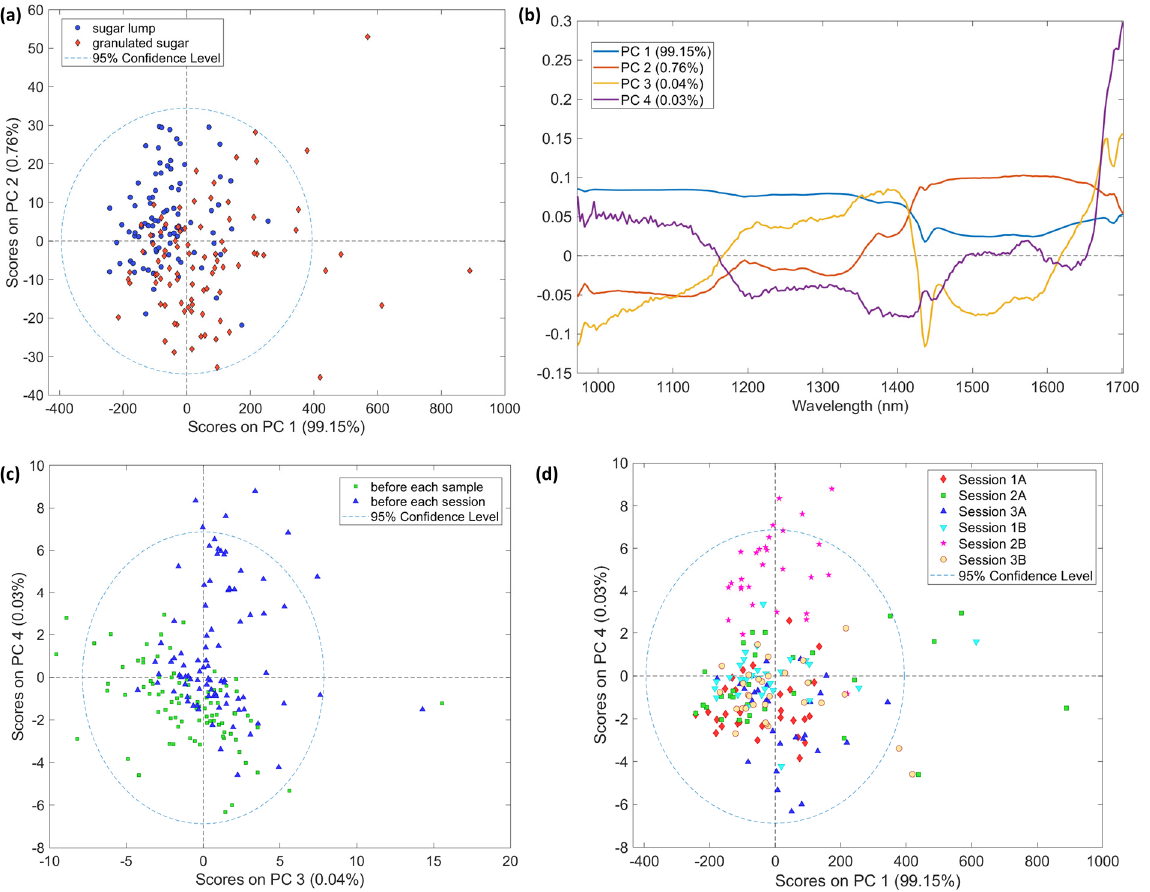
Figure 2. PCA models on AvaSpec − Mini − NIR spectra. ( a ) Score plot PC1 vs. PC colored by samples; ( b ) Line loading plot; ( c ) Score plot PC3 vs. PC4 colored by time of background; ( d ) Score plot PC1 vs. PC4 colored by session and time of background where A and B in the legend stands for background before each sample and before each session, respectively.